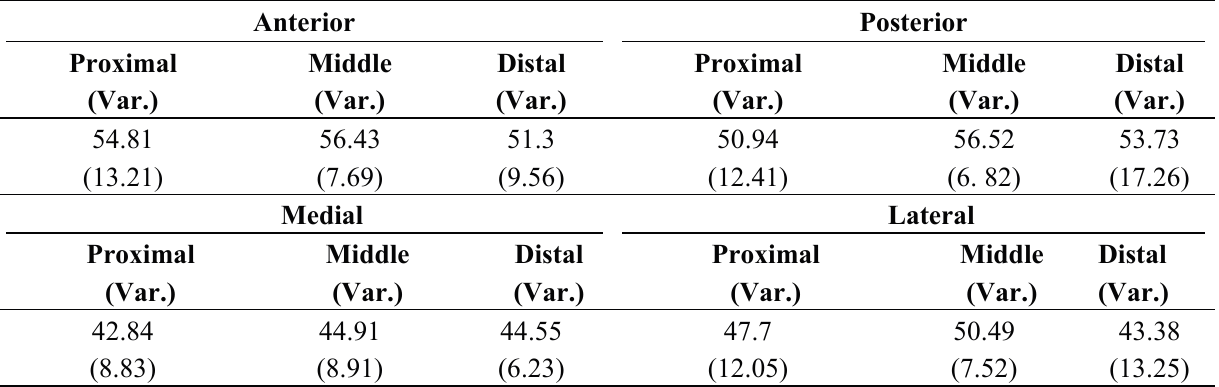
Table 2. The average peak pressure (kPa) for all sensors sites at the medial and lateral anterior, posterior, residual